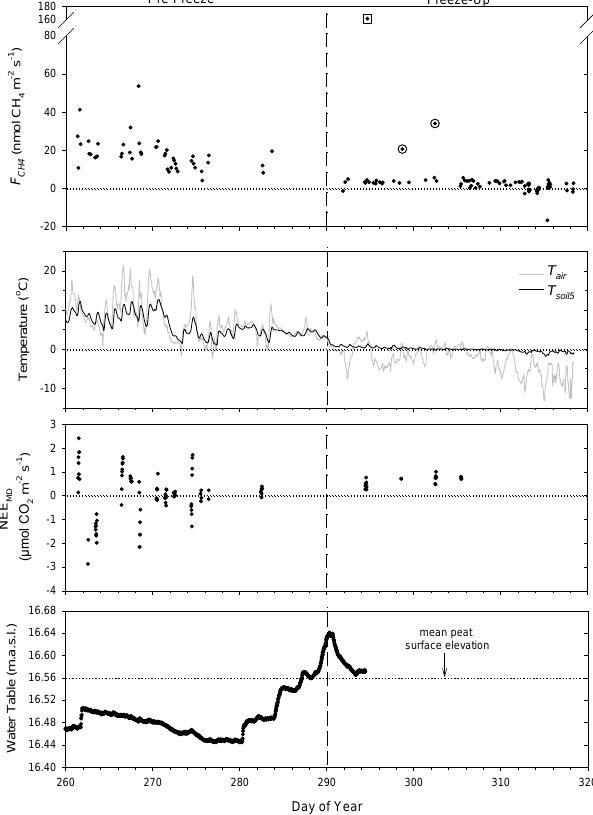
Fig. 3. Fall of 2011 30min F CH , T air , T soil5 , NEE MD and water 4 table height for the fen from 17 September to 16 November 2011 (DOY 260–320). Open square indicates an anthropogenic emission burst, while open circles indicate natural emission